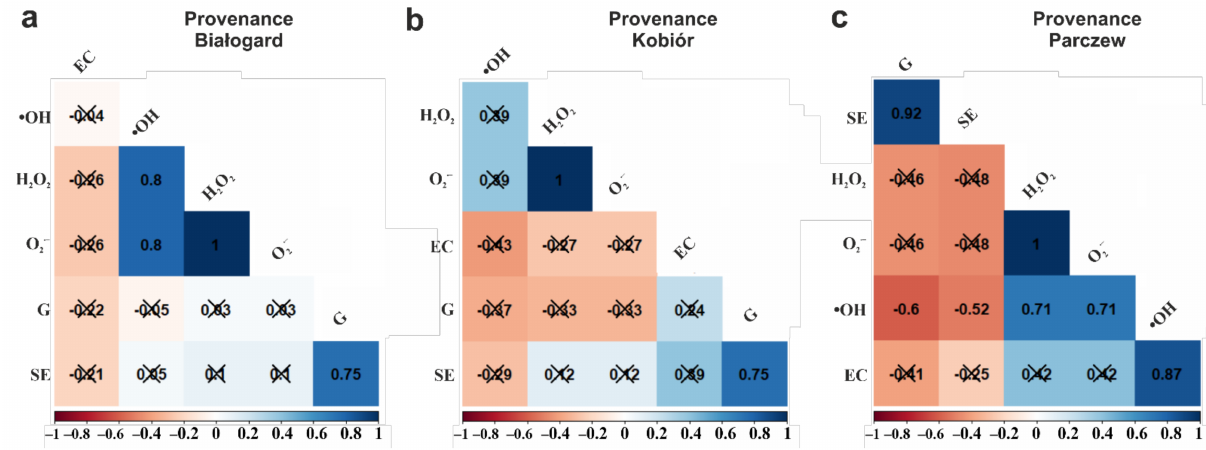
Figure 4. Correlation matrices calculated for pedunculate oak seeds originating from three provenances, ( a ) Białogard, ( b ) Kobi ó r and ( c ) Parczew, based on the levels of hydrogen peroxide (H 2 O 2 ), superoxide anion radical (O 2 •− ), hydroxyl radical ( • OH), electrical conductivity (EC), germination capacity (G) and seedling emergence (SE). The percentage of G, SE and EC was ArcSin transformed. Crossed numbers indicate a nonsignificant correlation ( p > 0.05). The more red the color is, the more negative the correlation, whereas the more blue, the more positive the